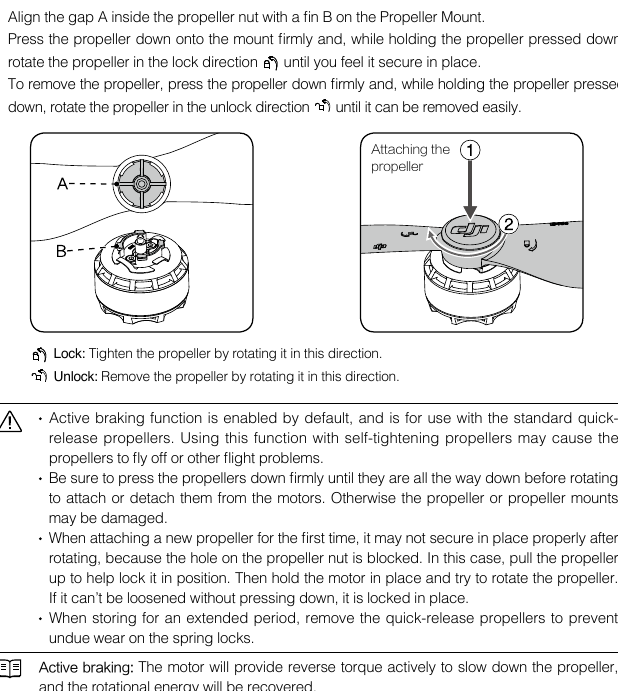
Clockwise Motor Counter- clockwise Motor